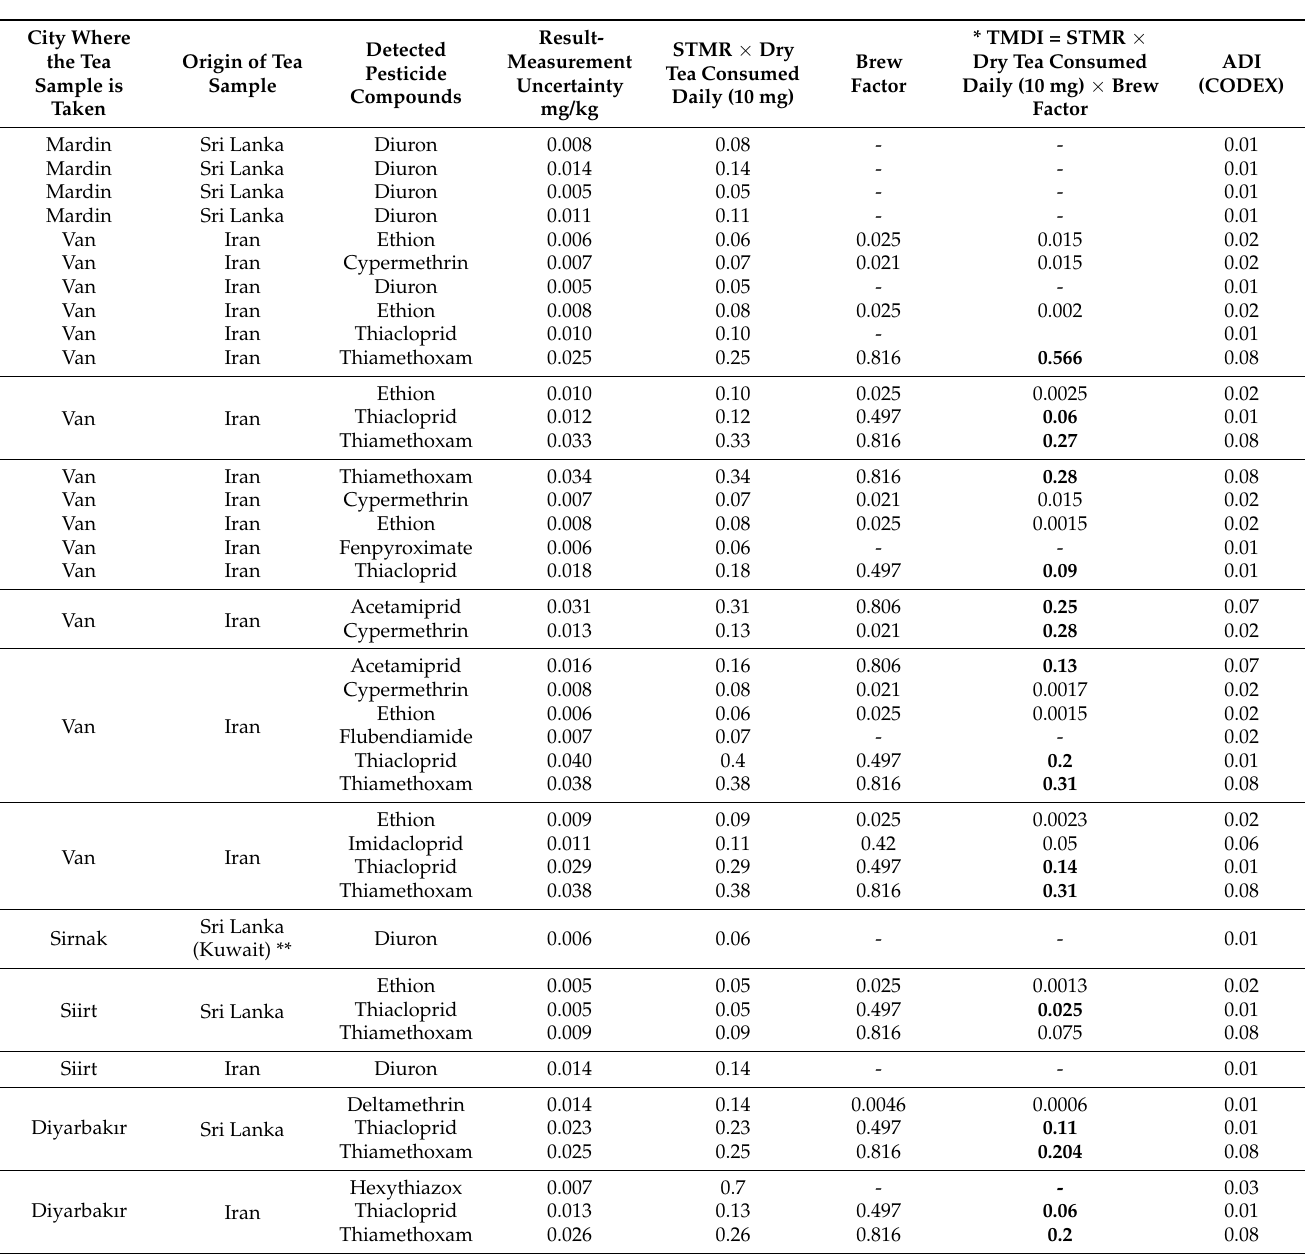
Table 2. Quantities of pesticides detected by LC-MS/MS and GC-MS analysis and risk assessment according to the ADI values specified by Codex